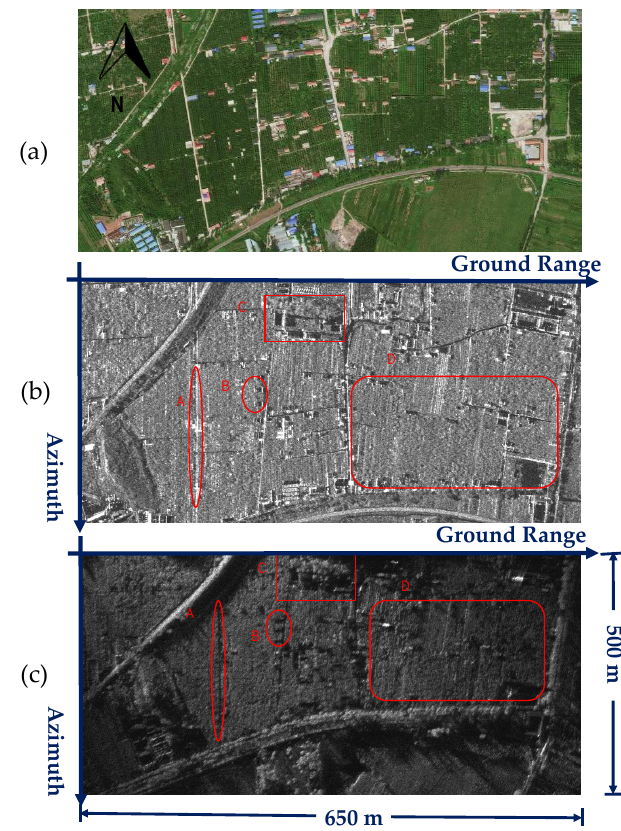
Figure 11. Comparison of: ( a ) the optical image; ( b ) the MonoSAR image (provided by DLR); and ( c ) the compensated BiSAR